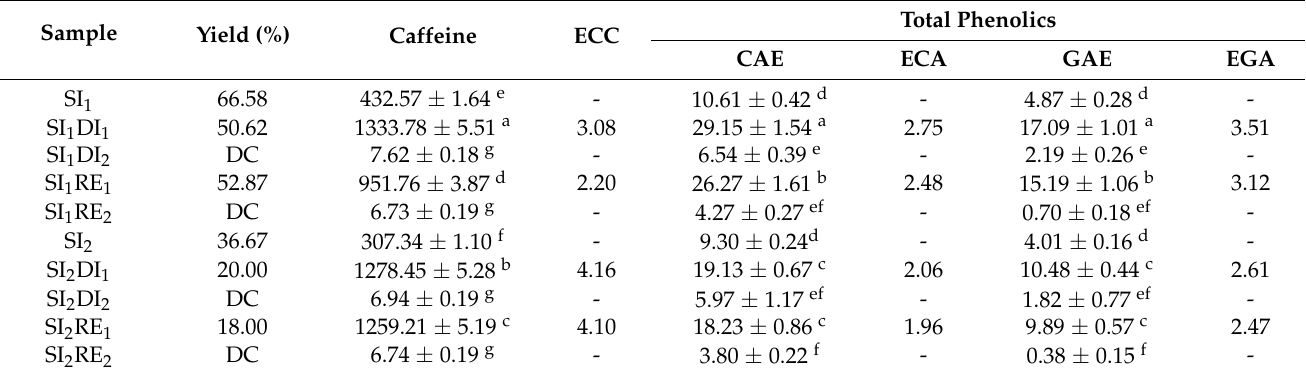
Table 2. Caffeine and total phenolics content of SI crude and enriched extracts.